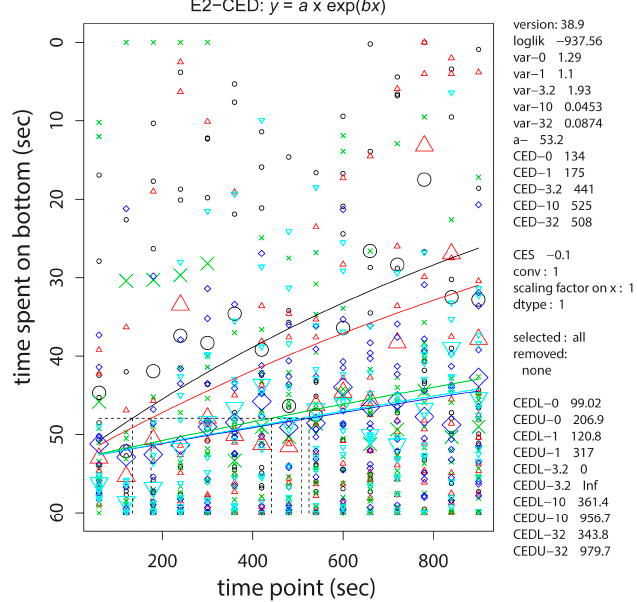
Figure 4. Bottom dwelling response of embryonically cadmium exposed adult zebrafish after transfer to a novel environment. Each column of data points represents time spent in the bottom third of the tank in the preceding 60 s. Small and large circles are individual and median values, respectively. The embryonic exposure groups are statistically significantly separated and are shown in black, red, green, dark blue, light blue, representing 0, 1, 3.2, 10, 32 μ M of embryonic CdCl 2 exposure, respectively.